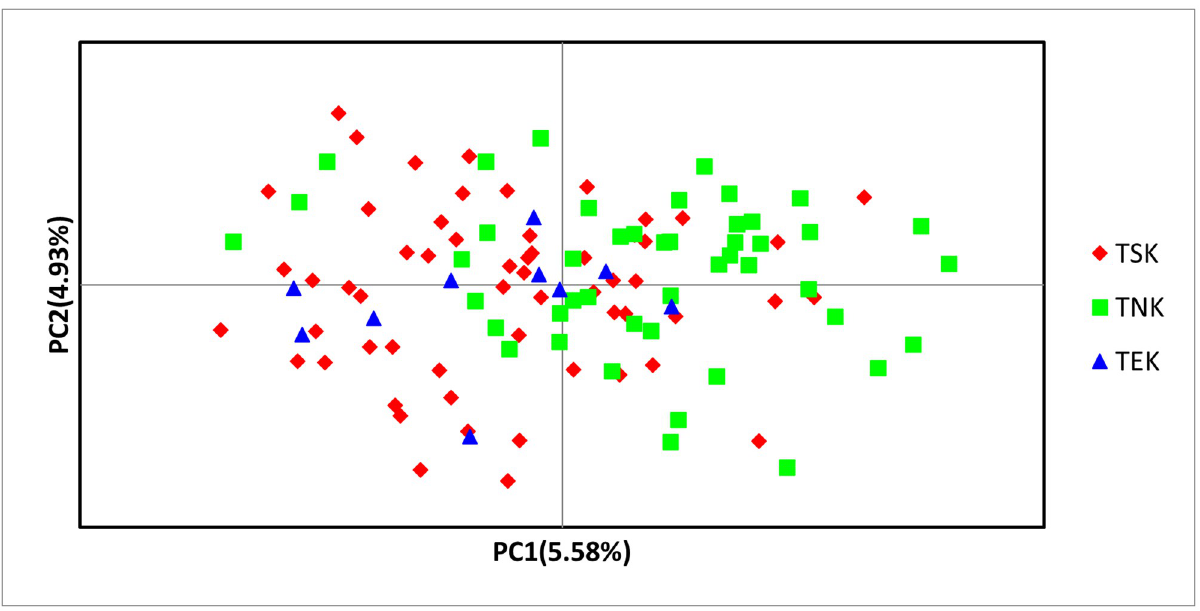
Fig 2. PCoA plot of 114 Tazy dogs from three different subpopulations based on STR data.